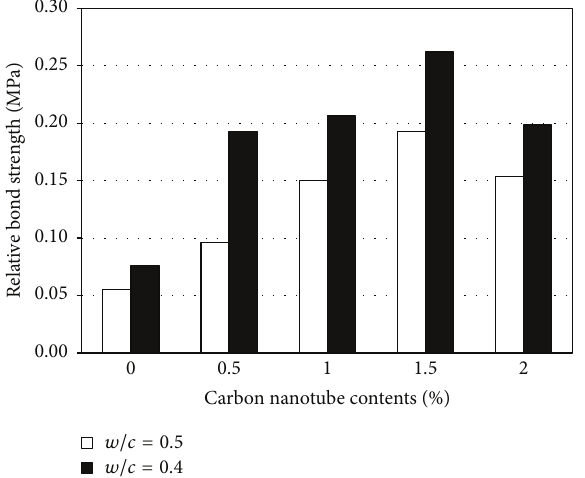
Figure 6: Relative bond strength of macrosynthetic fiber in LMH-